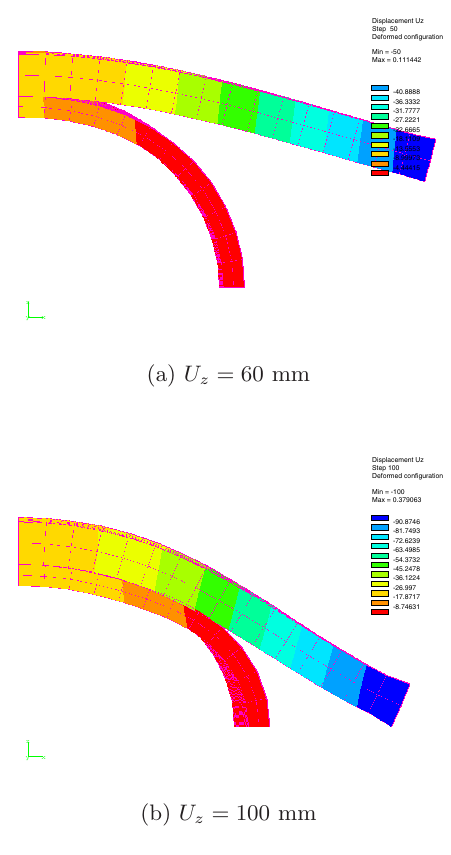
Fig. 17. Pinch of pipes: deformed